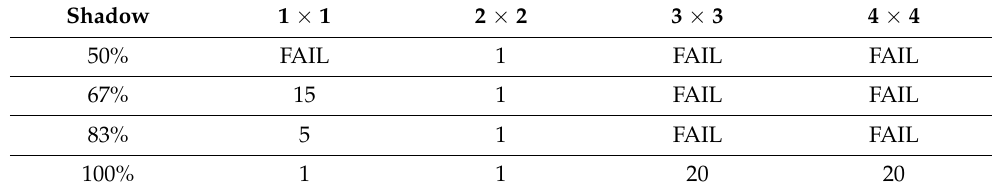
Table 2. Recognition time (s) for each different block matrix size, over different light conditions. Shadow